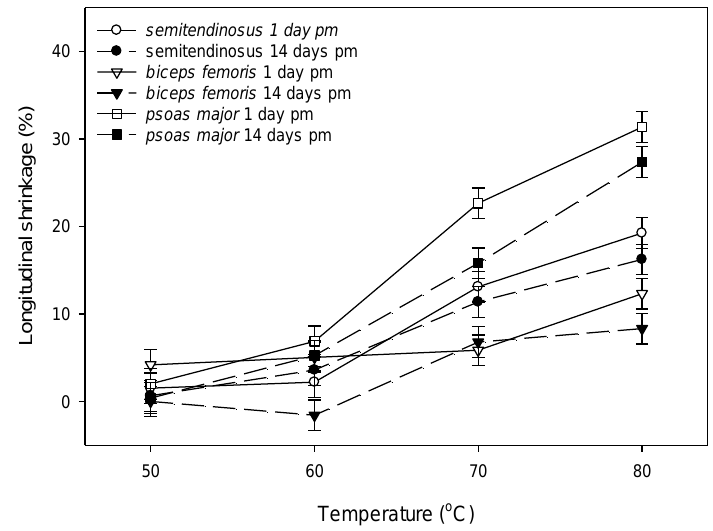
Figure 4. Effect of ageing (1 day post mortem vs. 14 days post mortem) and cooking temperature (50 °C, 60 °C, 70 °C and 80 °C) on longitudinal shrinkage of bovine semitendinosus , biceps femoris and psoas major . Cooking time was 30 min. after reaching the defined temperature (Tc + 30 min.). Values are least square means and vertical bars are least significant differences (LSDs) for the three-way interaction muscle × ageing × temperature. Main and interactive effects were as follows: p (muscle) < 0.001, p (ageing) = 0.052, p (temperature) < 0.001, p (muscle × ageing) = 0.063, p (muscle × temperature) < 0.001, p (ageing × temperature) < 0.633, p (muscle × ageing × temperature) = 0.002.